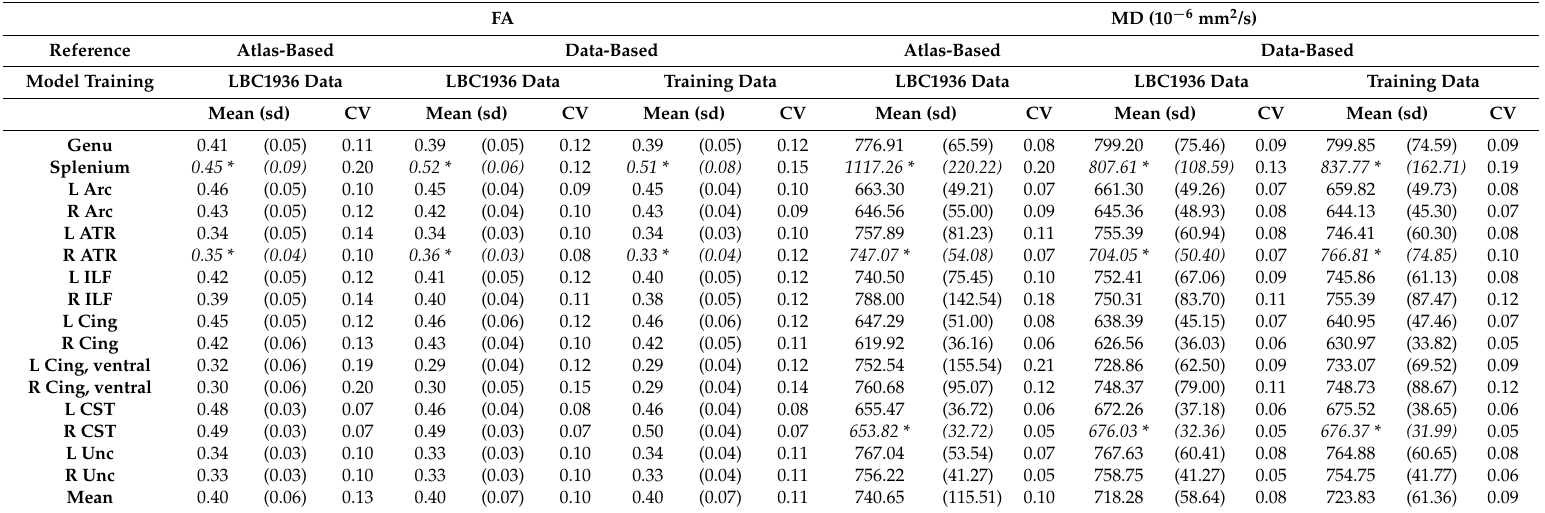
Table 2. Averaged values of fractional anisotropy (FA) and mean diffusivity (MD) measured along the tracts segmented with two different matching models, and atlas-based or data-based reference tracts as priors in 50 older age volunteers